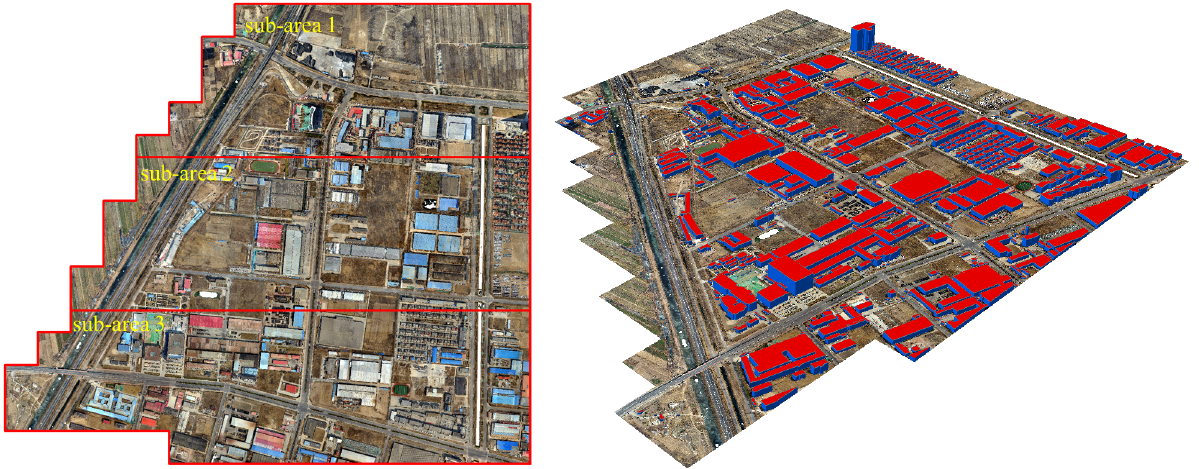
Figure 2. The digital orthophoto image of the study area (left) and the 3D building ground truth (right) which has been carefully edited and reviewed by the operators.